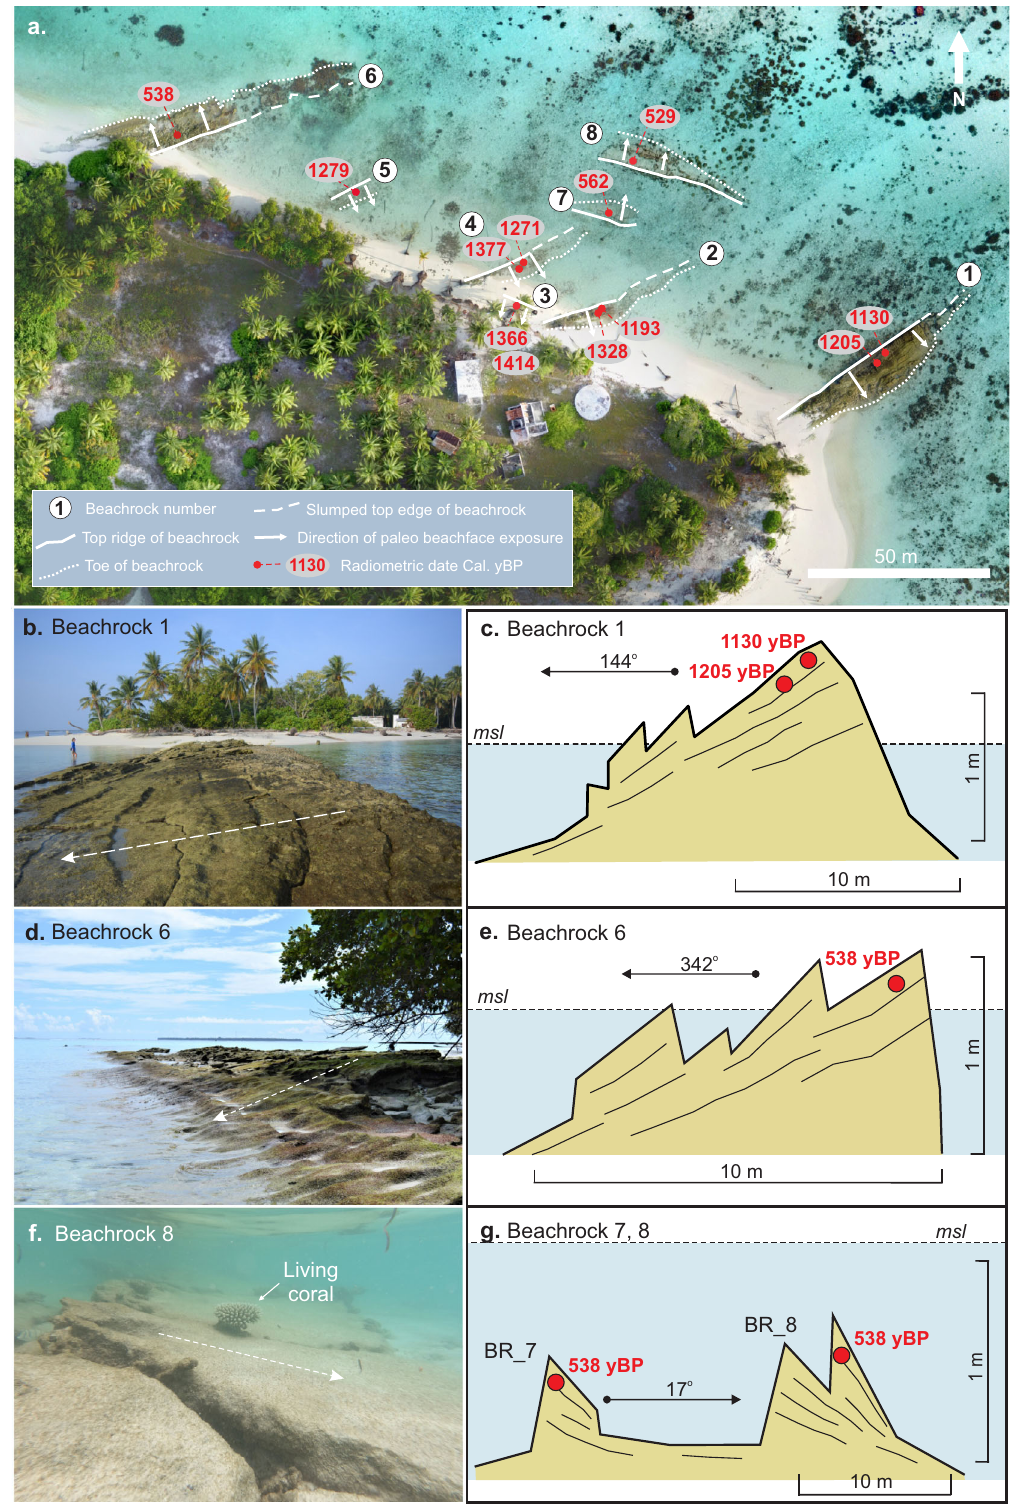
Fig. 3 | Summary locations and characteristics of beachrock outcrops on Kandahalagalaa. a Summary location and orientation of beachrock units. Note: arrows show the direction of exposure of beachrock slope. Source: author drone image. b , c Oblique photograph and survey cross-section of beachrock 1 on the